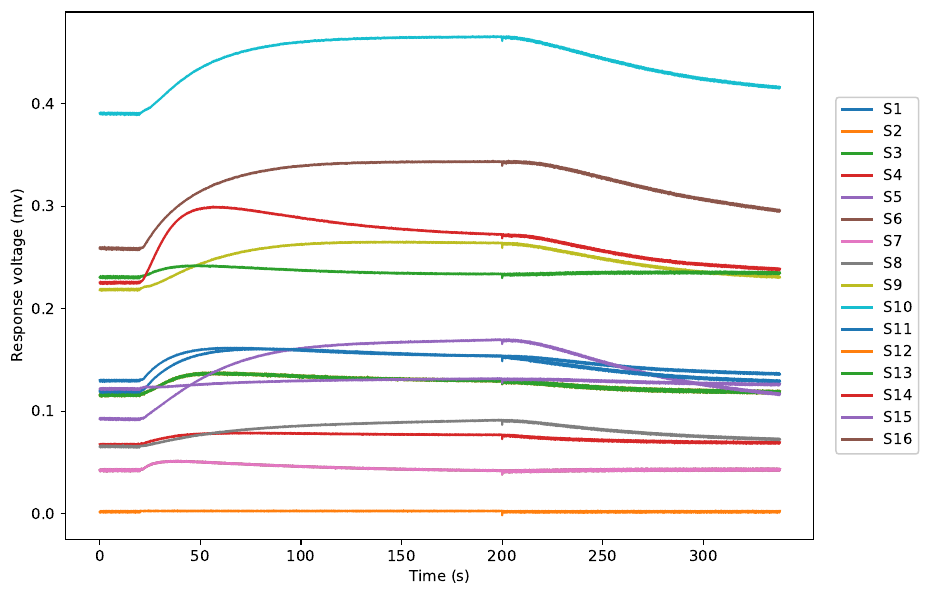
Figure 3. A typical E-nose response curves from a dendrobium gas